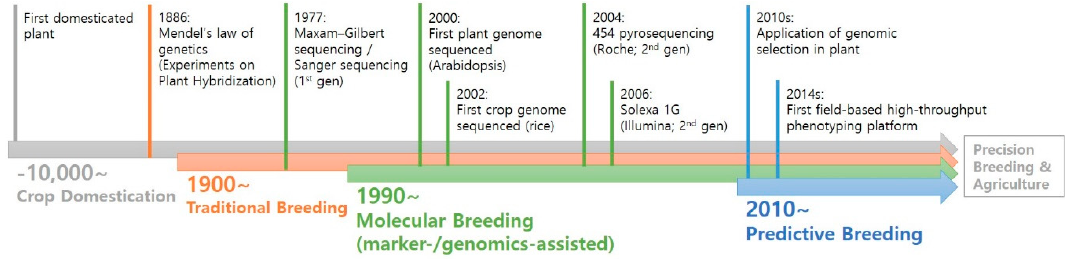
Figure 1. Key technological milestones in plant breeding.